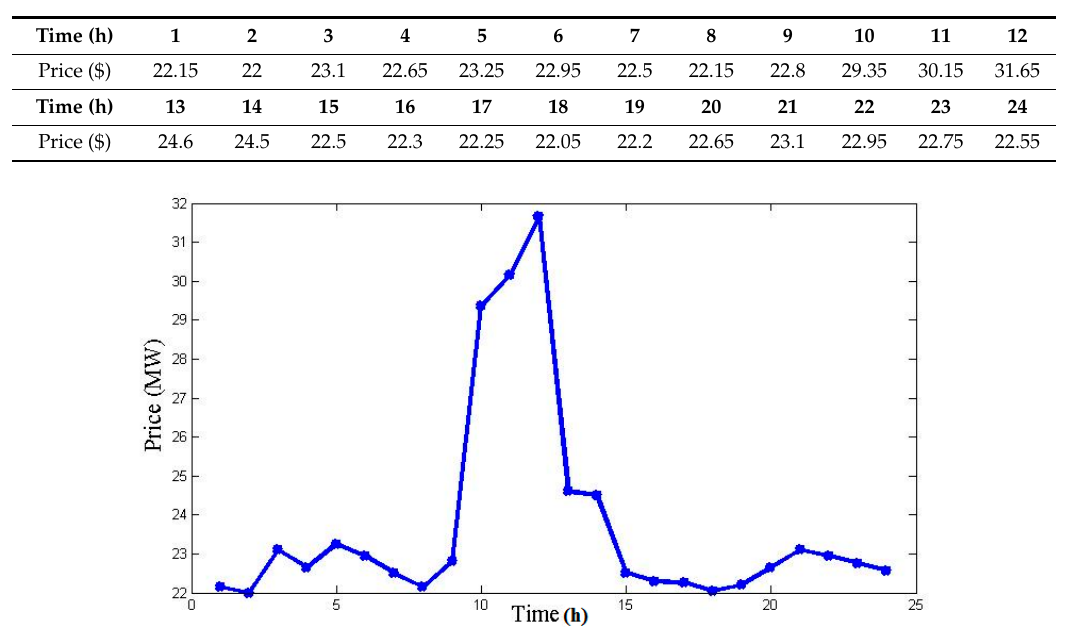
Table 4. Forecasted price values for 24 h.